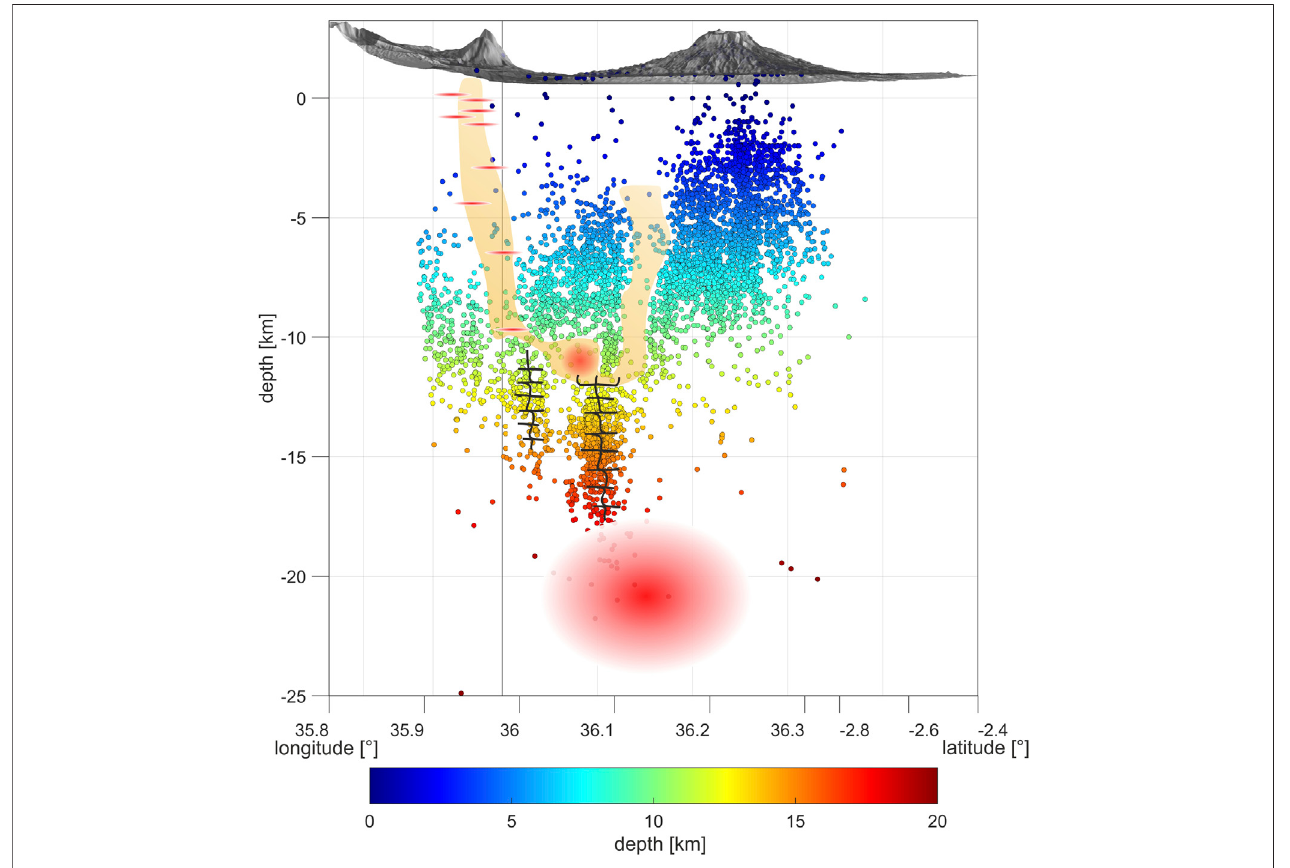
FIGURE 12 | Plumbing system of Oldoinyo Lengai with seismicity. The orange shaded areas are seismic gaps interpreted as part of the mushy plumbing system, overlain with small reddish ellipses denoting sill complexes. Black lines denote deep plumbing system, which connect the hydrothermal system to the deep magma chamber inferred from Roecker et al.